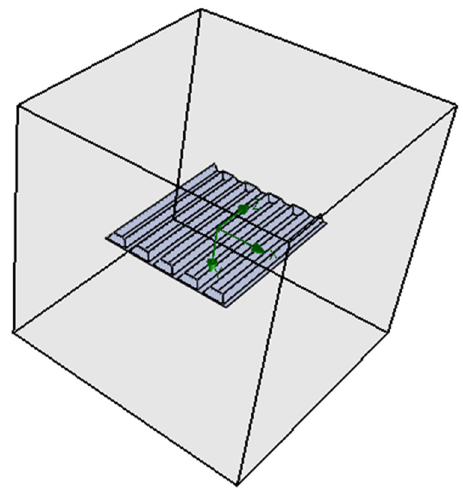
Figure 4: The scope of simulation.